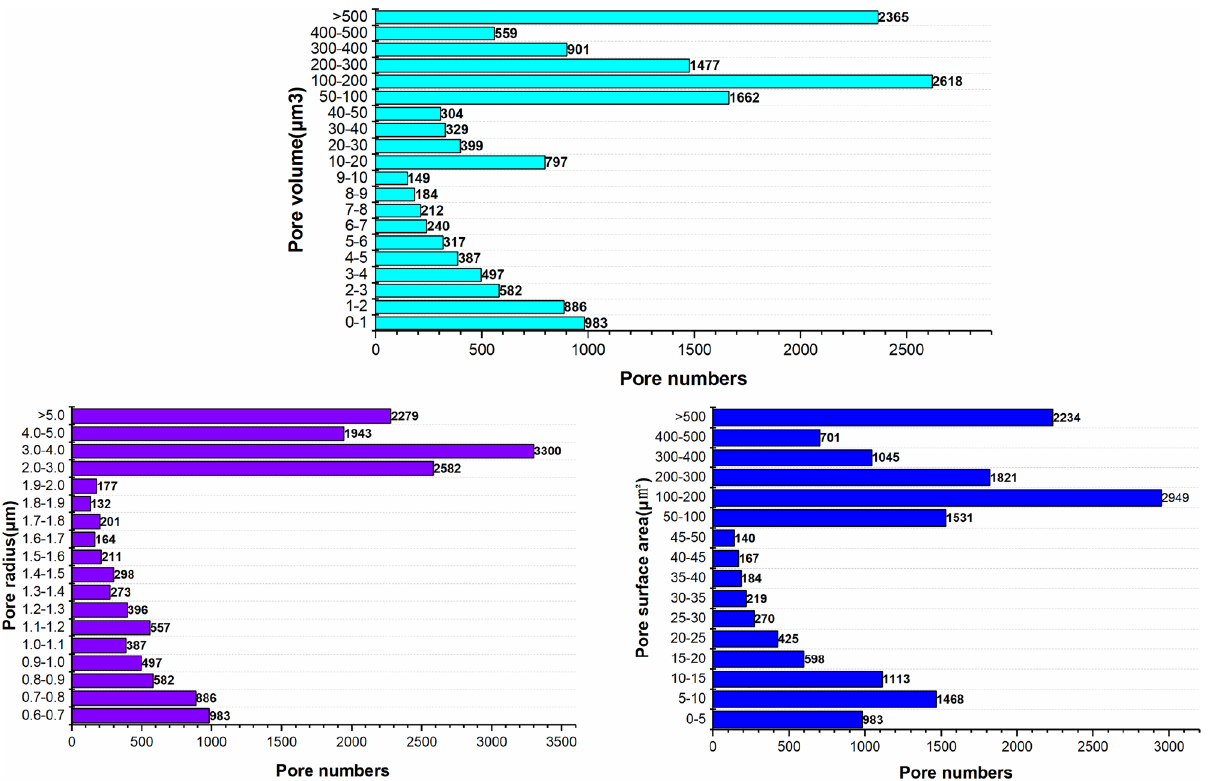
Figure 11. Statistics of pore quantitative parameters in pore network model.